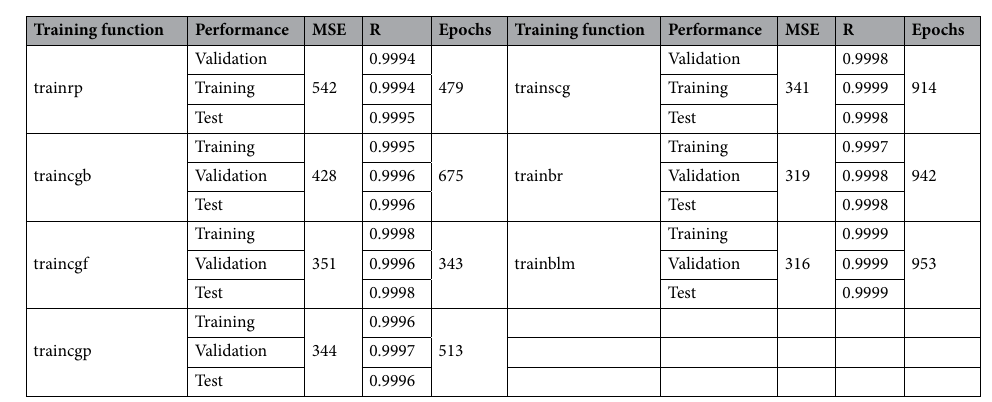
Figure 12. ANN inputs.